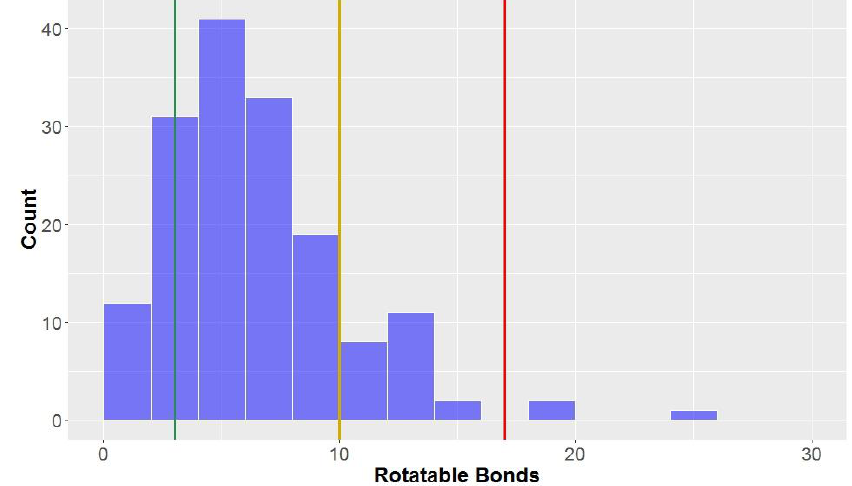
Figure 8. The statistical distribution of the rotatable bonds of all analysed compounds (green = 3, compounds < 3 are in the lead-like space; yellow = 10, compounds < 10 are in the drug-like space; red = 17, compounds < 17 are in the known drug space). Total number of compounds = 160.